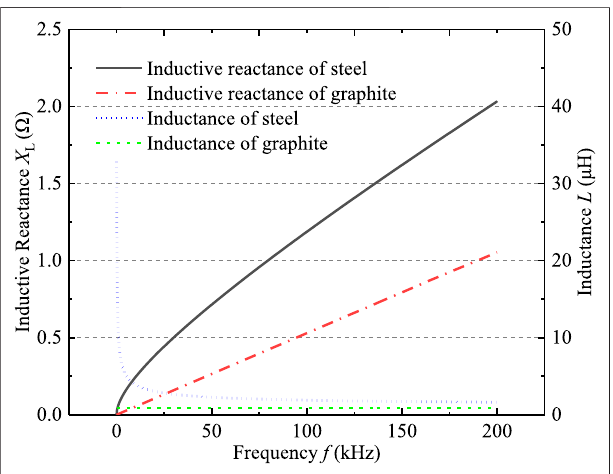
FIGURE 11 | Effect of frequency on the inductance of the grounding